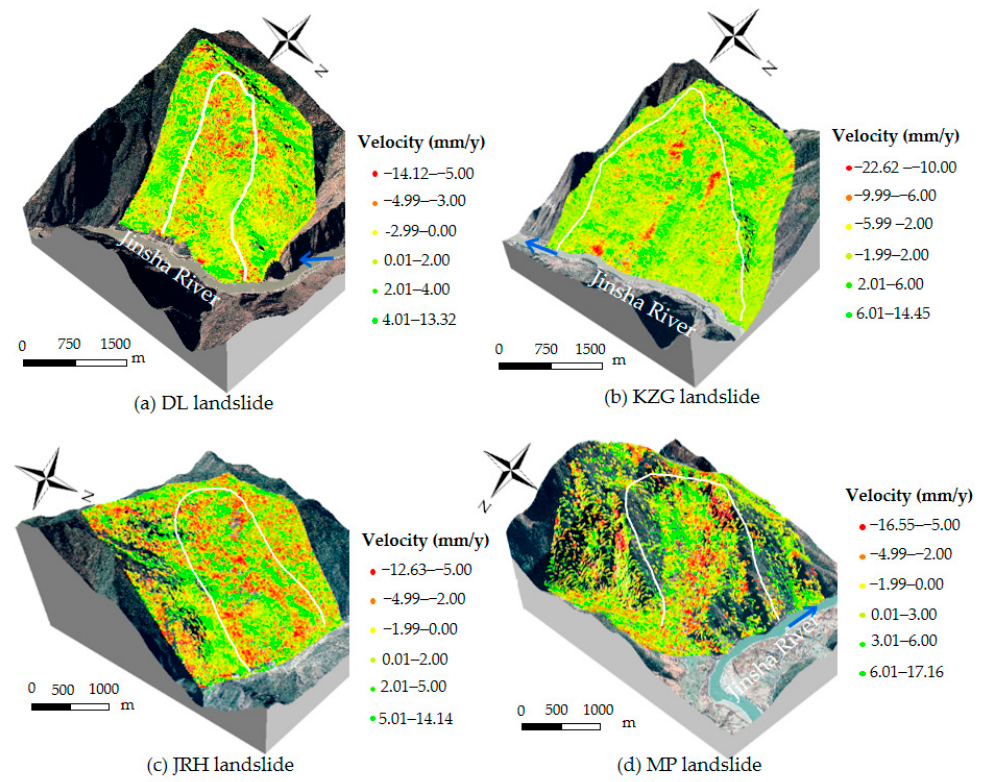
Figure 5. Deformation features of old landslide deposits with ALOS-2